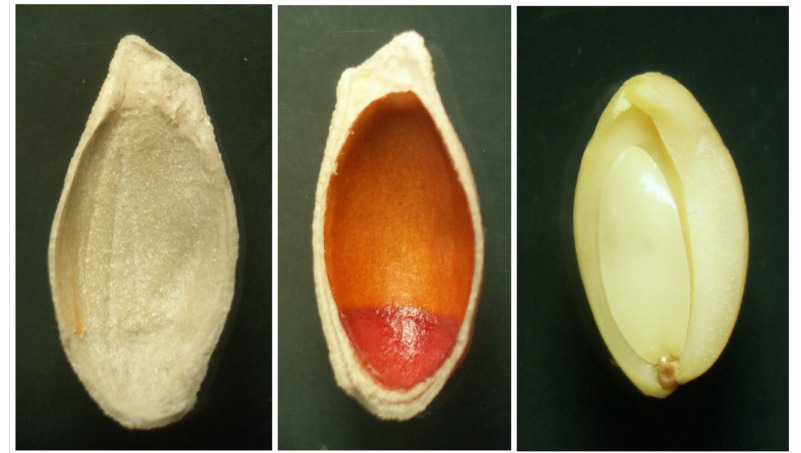
Figure 3. Photographs of the outer seed coat ( left ), inner seed coat (orange) ( middle ) and endosperm ( right ) of the lemon seed.